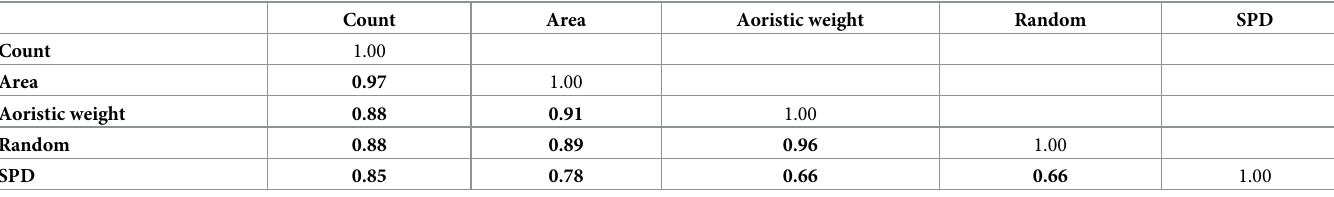
Significant correlations indicated by bold numbers (p-value <